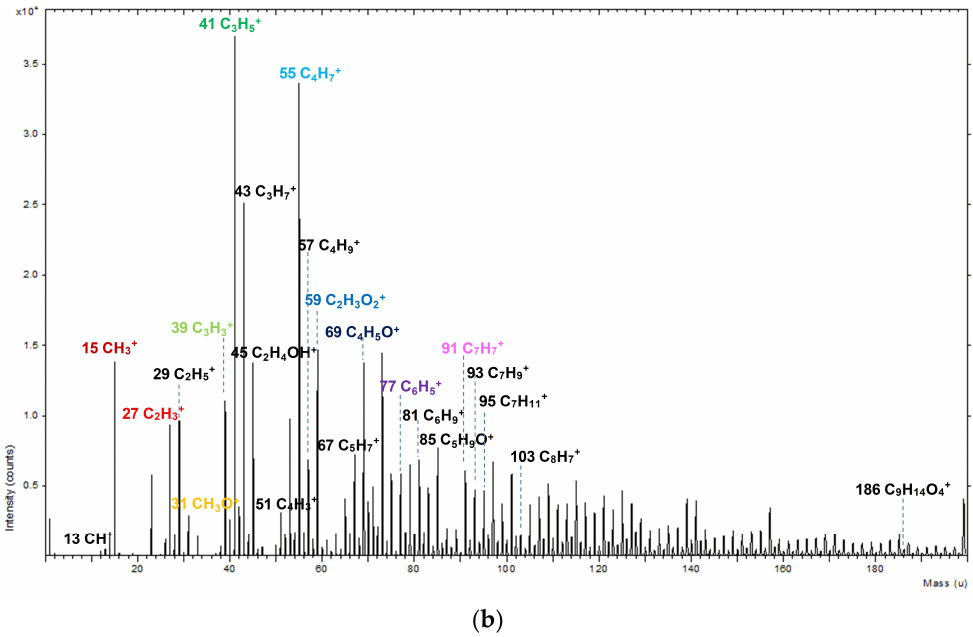
Figure 3. ( a ) Negative-ion and ( b ) positive-ion spectra (0–200 amu) of time of flight-secondary ion mass spectrometry (ToF-SIMS) on the surface of pPMMA thin films grown on a glass substrate when using the proposed APP polymerization technique after 90 min deposition.